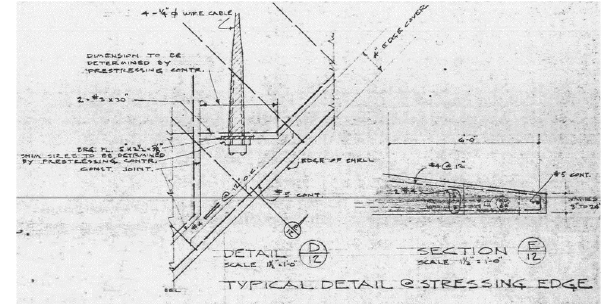
Figure 5: Typical Detail at Stressing Edge